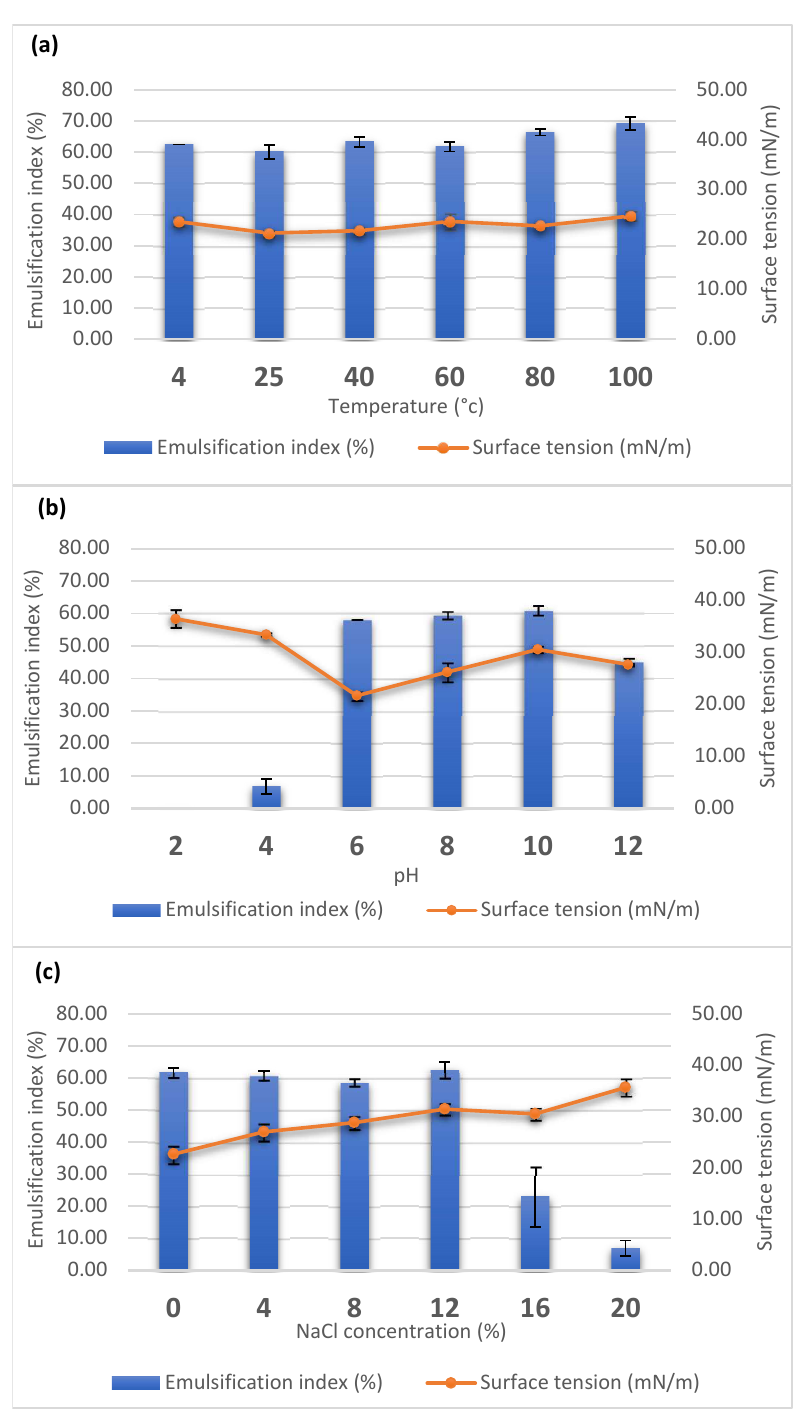
Figure 2. Effect of temperature ( a ), pH ( b ), and NaCl concentration ( c ) on the emulsifying index (%) and surface tension (mN/m) of PW192 biosurfactant. The bar and line plots represent emulsification index and surface tension, respectively. Data presented are the average of triplicate experiments, and error bars indicate standard deviation.